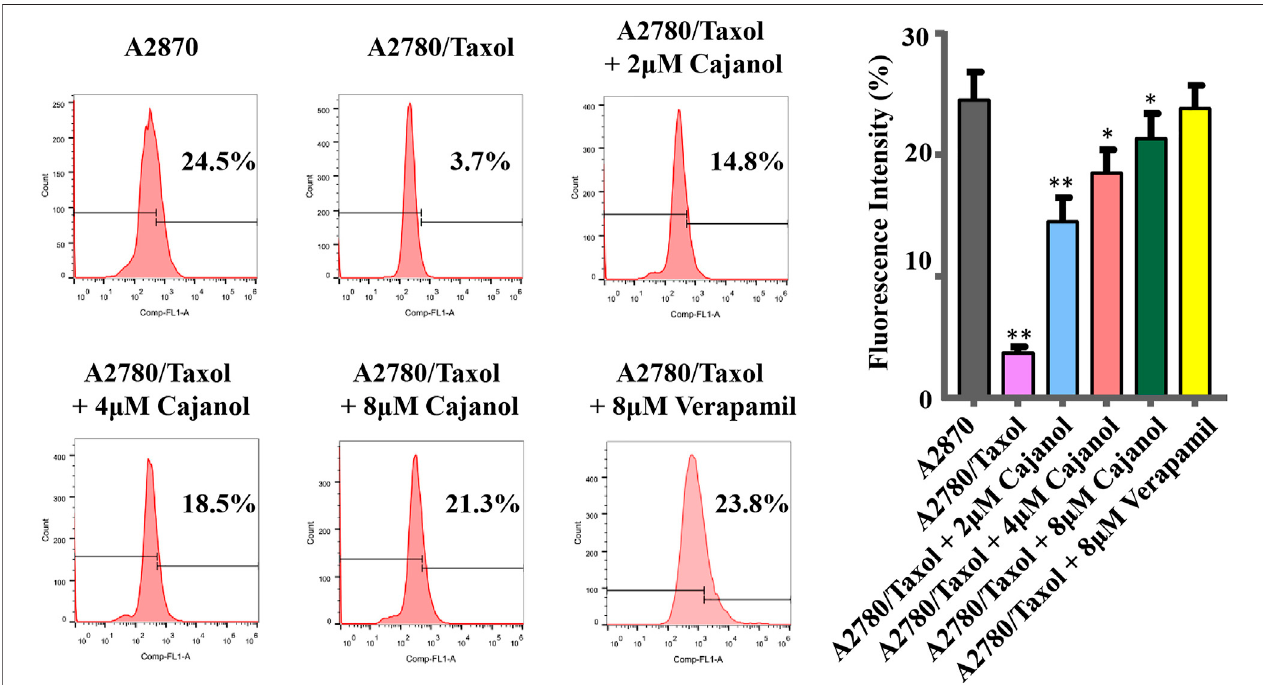
FIGURE 3 | Cajanol treatment down-regulates P-gp expression via inhibition of the PI3K/Akt/NF- κ B signaling pathway. Cajanol inhibits the phosphorylation of I κ B and the translocation of NF- κ B from the cytoplasm to the nucleus by inhibiting the expression of PI3K and the phosphorylation of Akt, and ultimately inhibits the transcription and translation of the P-gp protein.